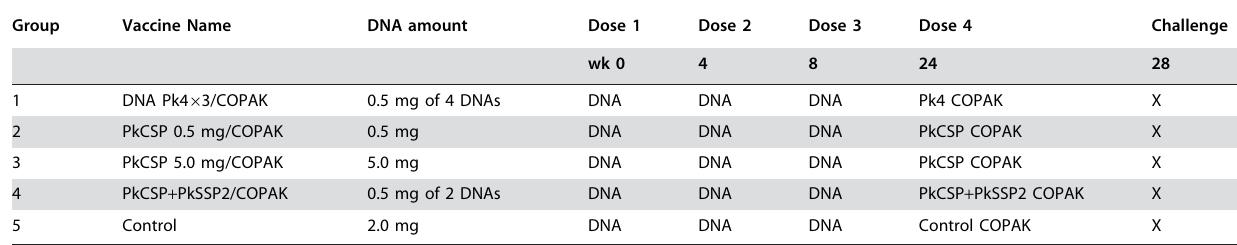
Five monkeys in each of five vaccine groups were immunized and challenged with Pk malaria sporozoites. The four antigen vaccine given Group 1 was identical to that given to Group 1 in Experiment 1. Group 2 received only the PkCSP components of the vaccine given to Group 1. Group 3 received a ten-fold larger dose of the PkCSP DNA than Group 2 and the same dose of PkCSP COPAK. Group 4 received only the PkCSP and PkSSP2 components of the vaccine given to Group 1. Group 5, the Control group, received a mock vaccine consisting of plasmid DNA without malaria antigen inserts followed by parental COPAK without malaria inserts. (See text for more details).